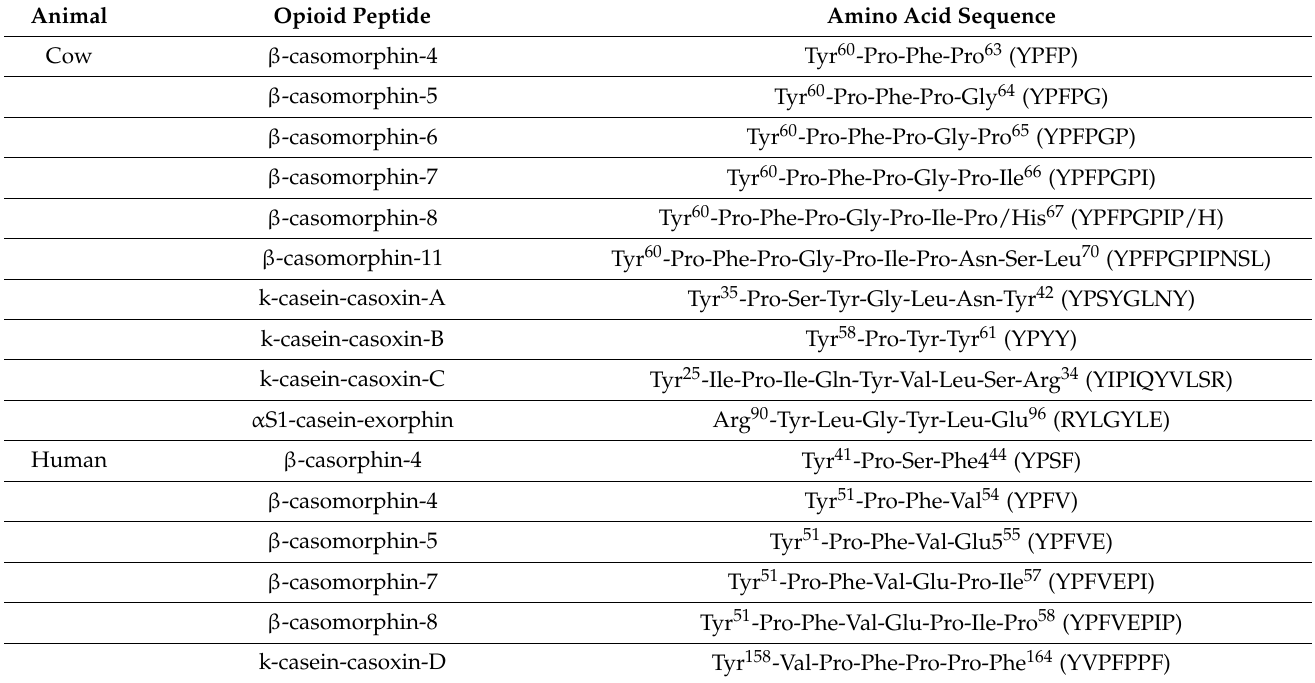
Figure 9. Selected enzymes and enzyme combinations involved in the proteolysis of cow β -casein leading to the release of β -casomorphins ( β -CM). Source: [133]. Reproduced with permission from Elsevier. Table 5. Opioid peptides reported to be derived from β -, α -, and α S1-caseins of cow and human